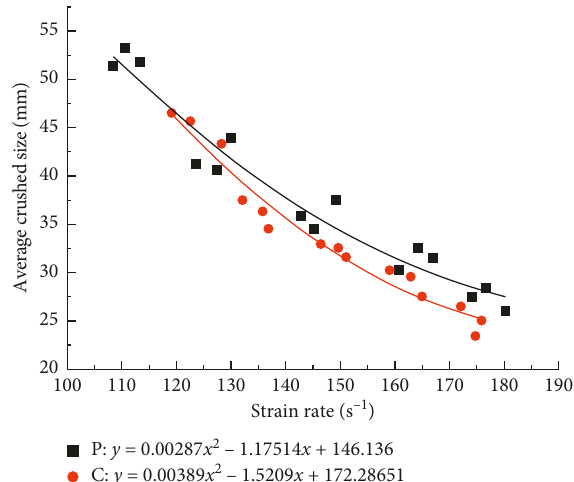
Figure 10: Relationship between the average crushed size and the strain rate of shale under dynamic compression loading of parallel (P) and vertical (C)